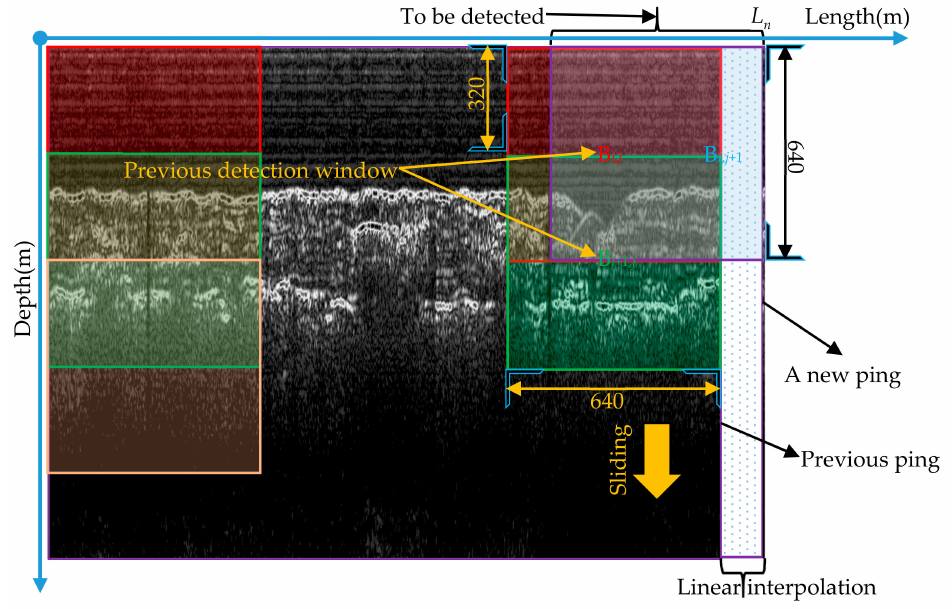
Figure 18. Schematic diagram of real-time pipeline inspection process.